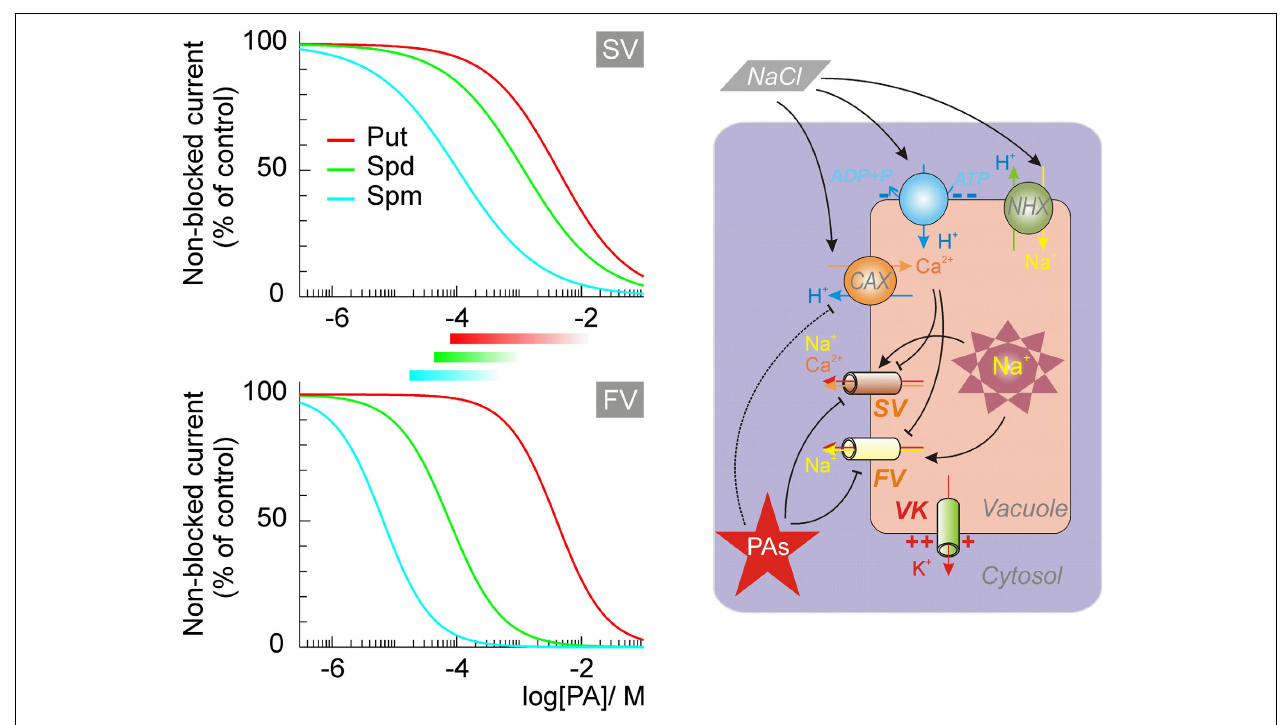
FIGURE 1 | The dose-dependence of the vacuolar cation channels’ block by intracellular polyamines and its implications for the salt stress resistance. Dose dependence for SV and FV channels at physiologically attainable (zero) tonoplast potential are drawn, using the values of blocking parameters from Brüggemann et al. (1998) and Dobrovinskaya et al. (1999a,b). Approximate ranges for intracellular PAs in plant cells are indicated by bars. At high salinity, efficient vacuolar Na + sequestration is critical for the salt tolerance. This requires the increased Na + /H + antiport activity and a decrease of Na + leaks through non-selective FV and SV cation channels. The